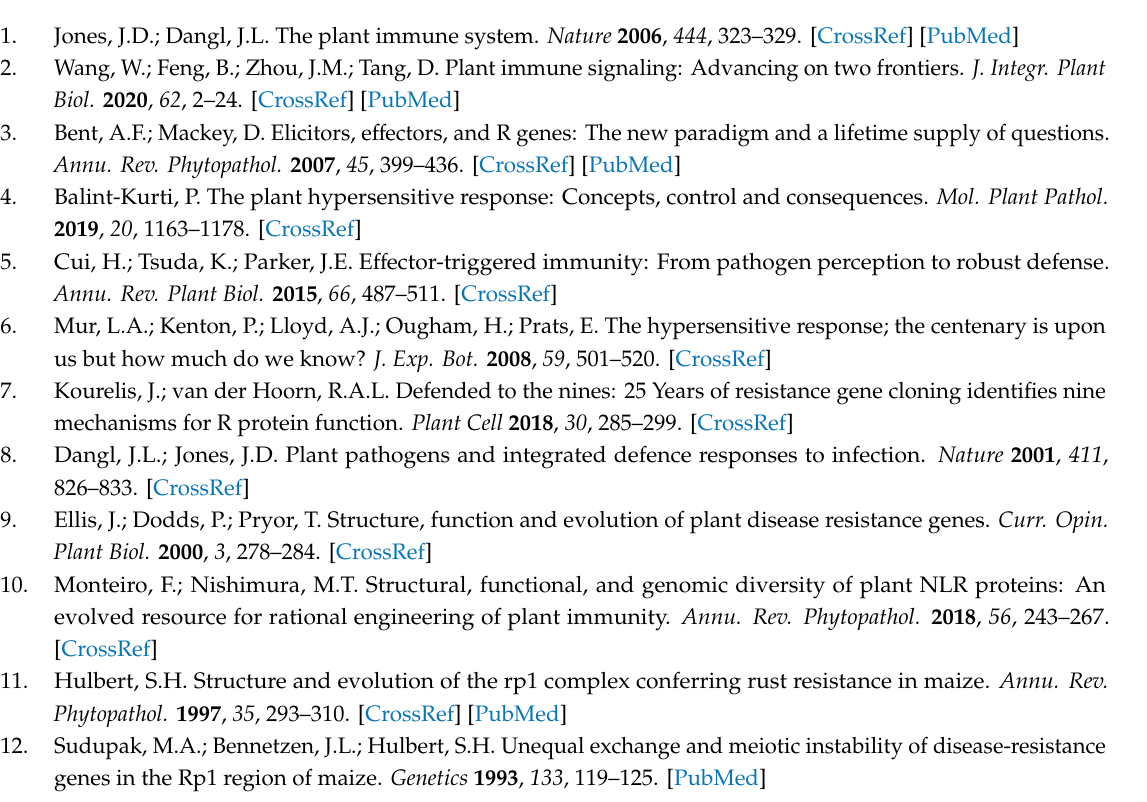
s1. Figure S1. Investigating the function of ZmFNSIs and ZmS3H in other elicitor-mediated HR. ZmFNSIs have no obvious suppressive roles on MLA(D502V)-, RPM1(D505V)-, INF1- or Bax-mediated HR. GUS, HCT1806, ZmFNSIs and ZmS3H were transiently co-expressed with RPM1(D505V), MLA(D502V), INF1 or Bax into N. benthamiana . The representative leaf was photographed at 3 days after inoculation. Figure S2. Investigating the interactions between HCT1806 or CCoAOMT2 and ZmFNSIs or ZmS3H. HCT1806 and CCoAOMT2 were constructed into pGBKT7 and ZmFNSIs and ZmS3H were constructed into pGADT7. T + 53 was used as the positive control. “ − ” indicated empty vector. Figure S3. Investigating the self-association of ZmFNSIs and ZmS3H. ZmFNSIs and ZmS3H were constructed into pGADT7 and pGBKT7 vectors. T + 53 was used as the positive control. “ − ” indicated empty vector. Figure S4. The subcellular localization of ZmFNSIs and ZmS3H. ZmFNSIs and ZmS3H were fused with C-terminal EGFP, and infiltrated into N. benthamiana transformed with nuclear marker H2B-TaqRFP. Confocal images were taken at 48 hpi. The position of the nucleus was labeled by arrows. The scale bar represents 50 µ m. The experiment was repeated three times with the same results. Figure S5. ZmFNSIs and ZmS3H did not change the subcellular localization of CC D21 . ZmFNSIs:EGFP or ZmS3H:EGFP were co-infiltrated with CC D21 :TaqRFP into N. benthamiana , and confocal images were taken at 48 hpi. The positions of the nuclei were labeled by arrows. The scale bar represents 50 µ m. The experiment was repeated three times with the same results. Table S1. The primers used in this